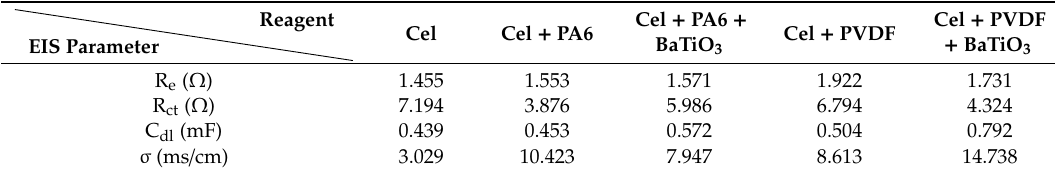
Table 2. Parameters of di ff erent types of friction